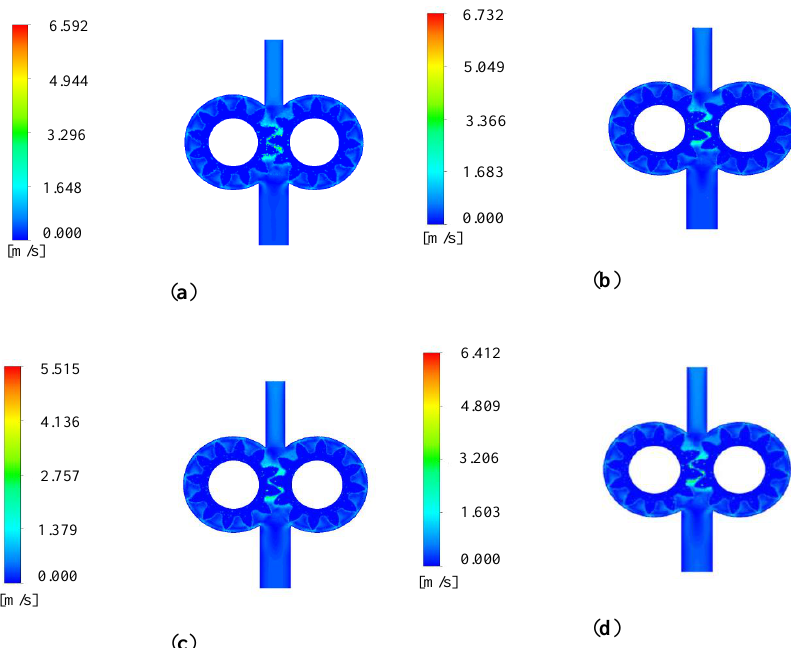
Figure 6. Velocity nephogram of 3D simulation model with 50% end face clearance: ( a ) velocity nephogram at 0.01 s; ( b ) velocity nephogram at 0.02 s; ( c ) velocity nephogram at 0.03 s; ( d ) velocity nephogram at 0.04 s.